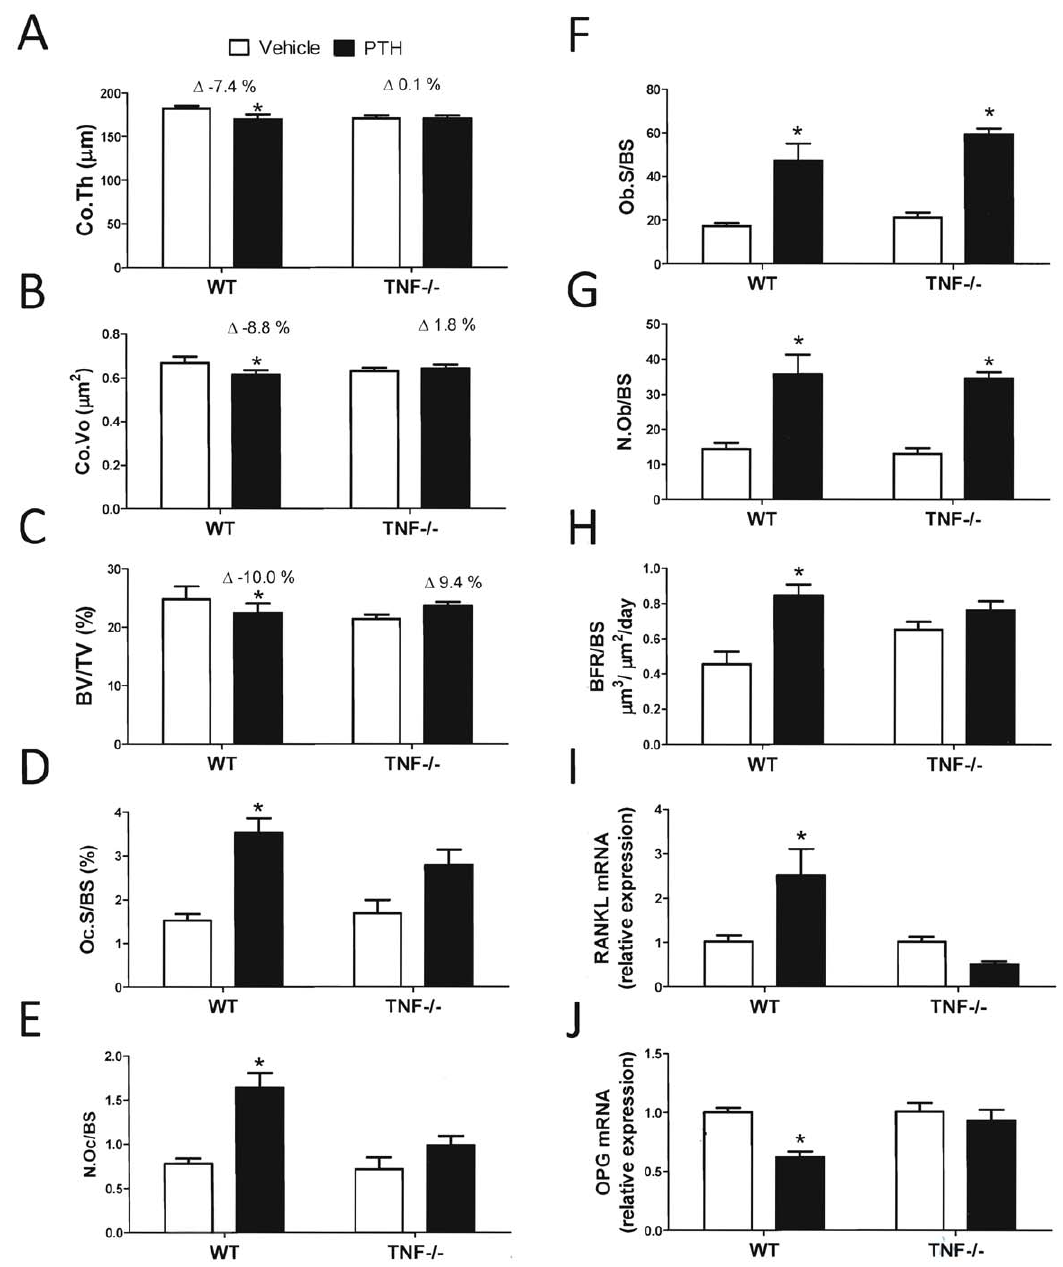
Figure 5. Effects of cPTH on bone structure and turnover in TNF 2 / 2 mice. A m CT analysis of femoral Co.Th. B m CT analysis of femoral Co.Vo. C m CT analysis of BV/TV. D Serum CTX levels. E Serum OCN levels. F–J Histomorphometric analysis of femoral trabecular bone. F: percentage of bone surface covered by osteoclasts (Oc.S/BS). G: number of osteoclasts per mm bone surface (N.Oc/BS). H: Bone formation rate (BFR). I: Percentage of bone surface covered by osteoblasts (Ob.S/BS). J: Number of osteoblasts per mm bone surface (N.Ob/BS). K–L mRNA levels of RANKL and OPG in SCs from WT and TNF 2 / 2 mice treated in vivo with vehicle or cPTH. *=p , 0.05 compared to the corresponding vehicle group. n=9–15 mice per group. Data are Means + SEM.